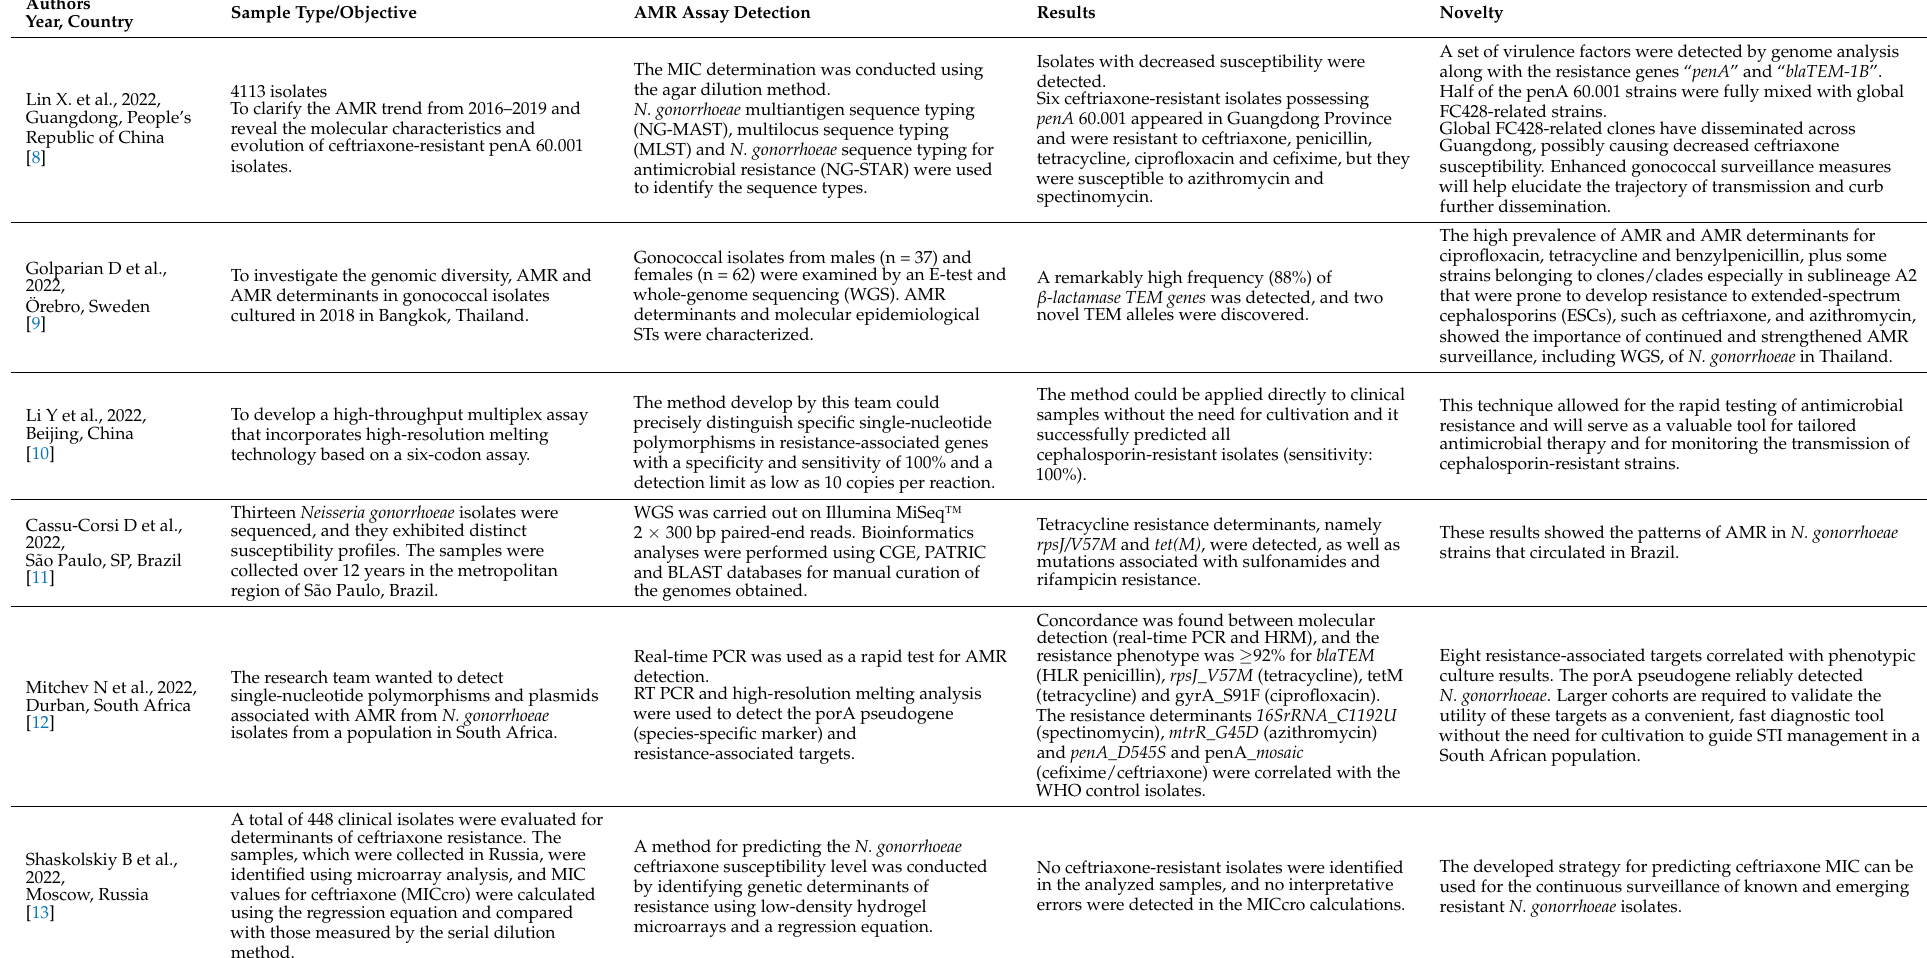
Table 1. AMR detection assays for Neisseria gonorrhoeae